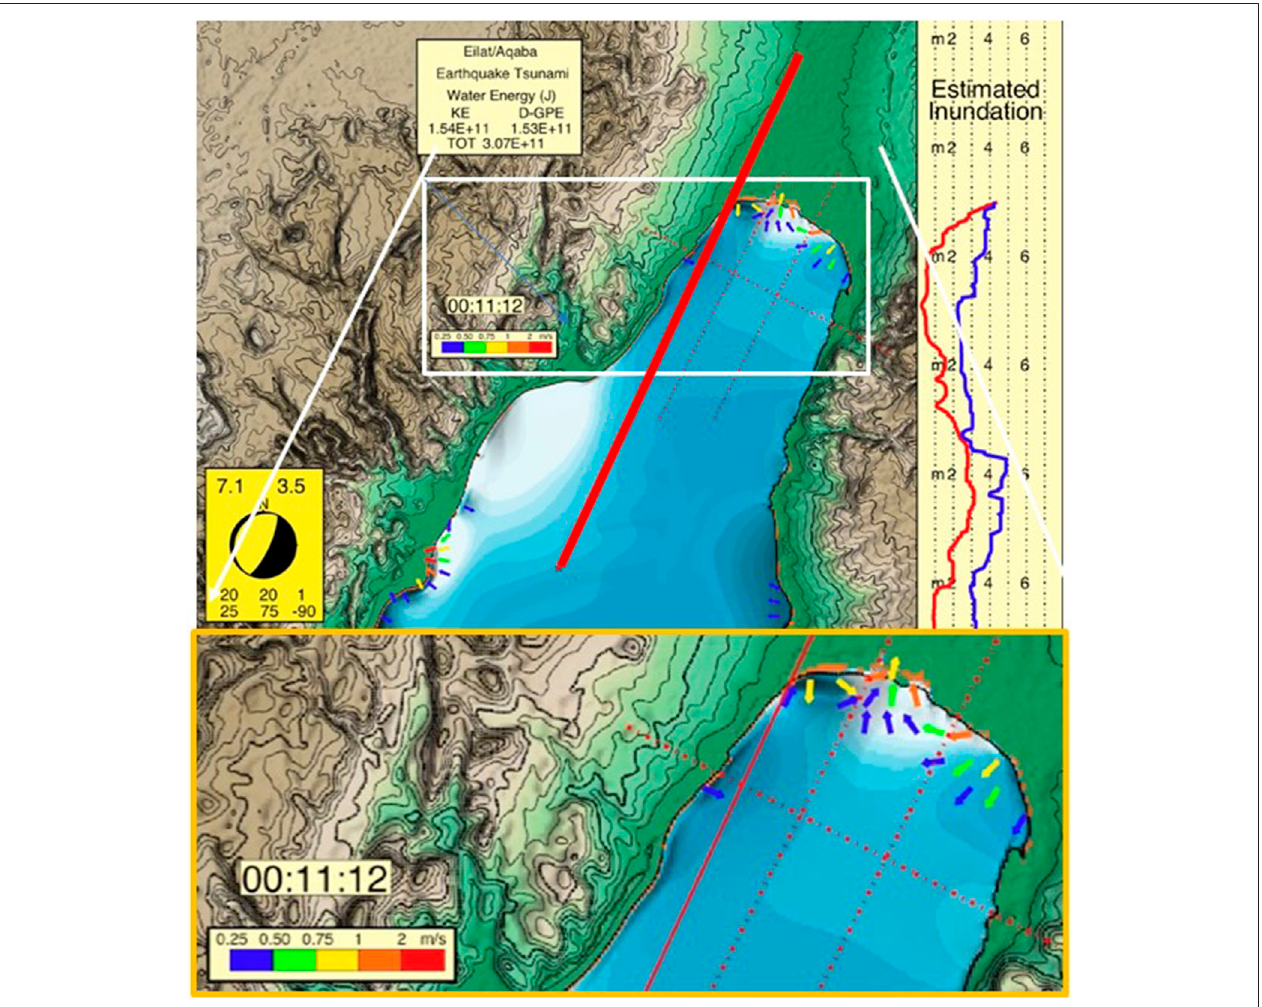
FIGURE 7 | Snapshot of the Elat fault (EF; red line) scenario at 11 min and 12 s after the start. Note the maximal wave heights achieved so far in this run along the westernand easterncoasts (redand blue lines, respectively,onthe right-side diagram).Flow velocities and directions alongthe coasts at this stage ofthesimulation are represented by small color coded arrows (enlarged map at the